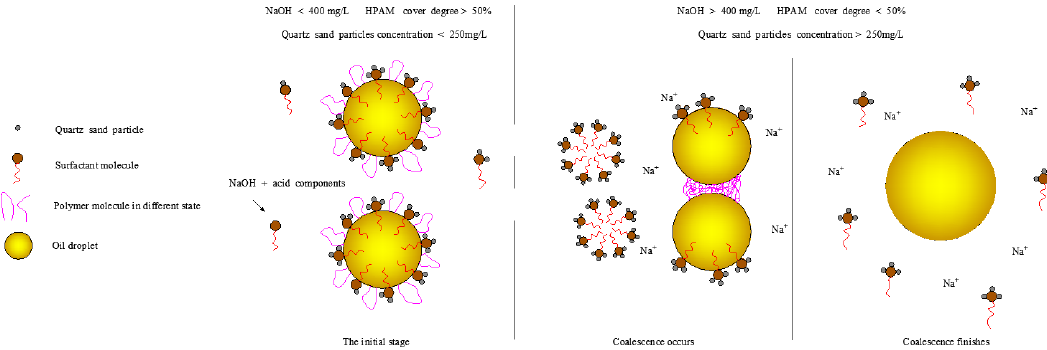
Figure 15. The mechanism of quartz sand particles and oil displacement agents on the stability of oil droplets in the alkali/surfactant/polymer (ASP)-flooding-produced water system.